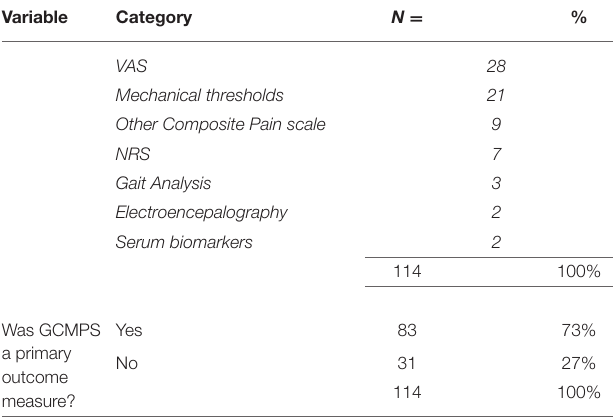
TABLE 1 | Variables describing the publications included in the